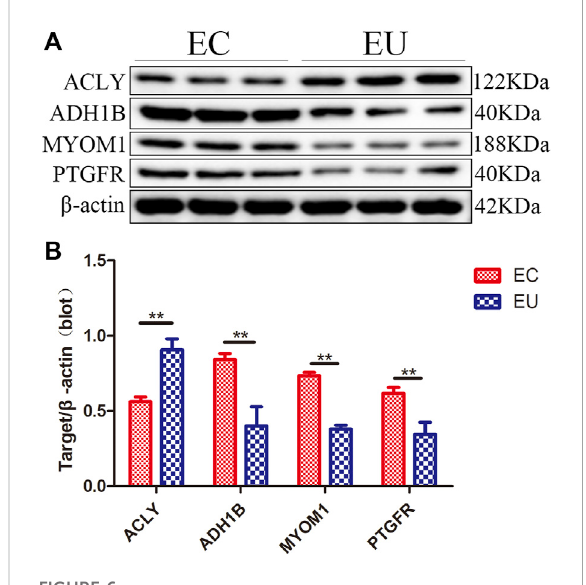
FIGURE 6 The results of western-blot to verify the expression of characteristic genes at the protein level; (A) Western blotting results; (B) Densitometry of the western blot; ** p < 0.01.